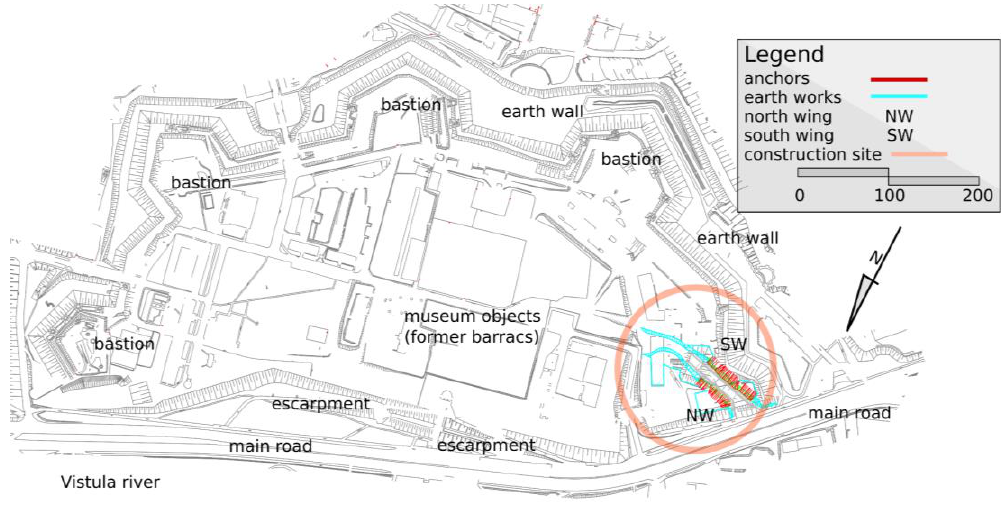
Figure 2. The detailed plan of Warsaw Citadel based on the design basis map (in Poland) at a scale of 1:500. The circle contains a newly designed entry into the backyard of the object.